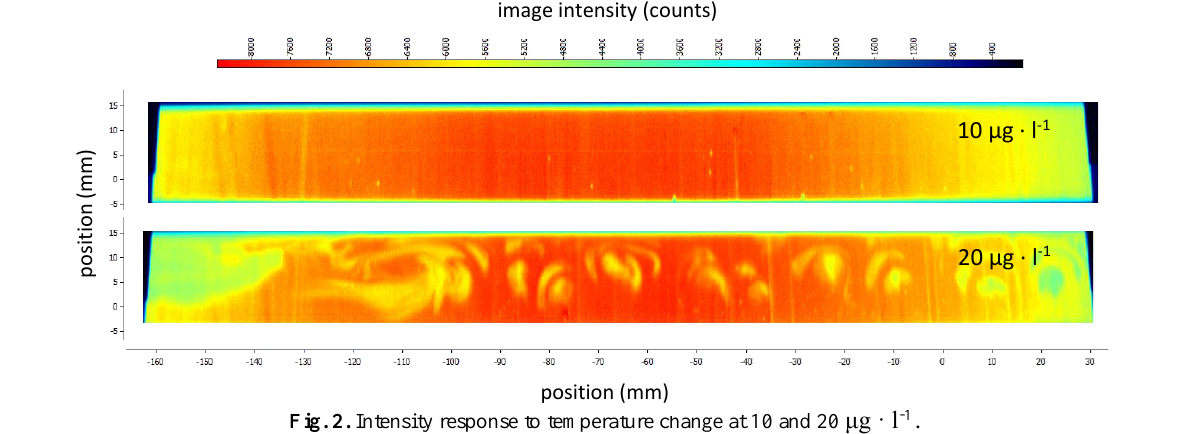
Fig. 2. Intensity response to temperature change at 10 and 20 μg · l -1 .